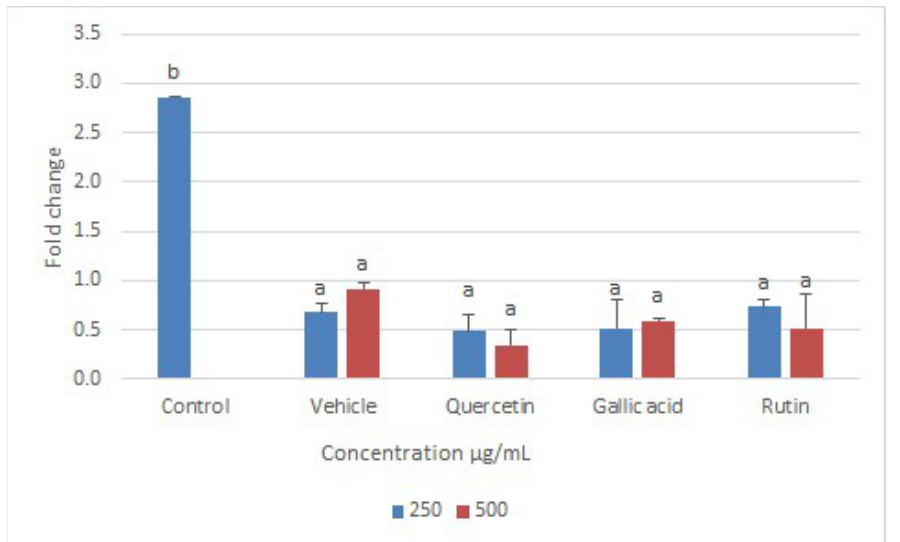
Figure 11. Fold change in expression level of trypanothione synthetase enzyme in Leishmania donovani after treatment with two different concentrations (250 µg/mL and 500 µg/mL) of quercetin, gallic acid, and rutin. Data represent the mean values of three replicates with ± standard error. Different labels on columns show significant difference at p < 0.05.